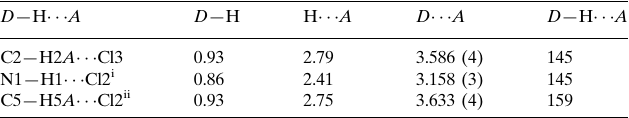
Hydrogen-bond geometry (A˚ , (cid:3)